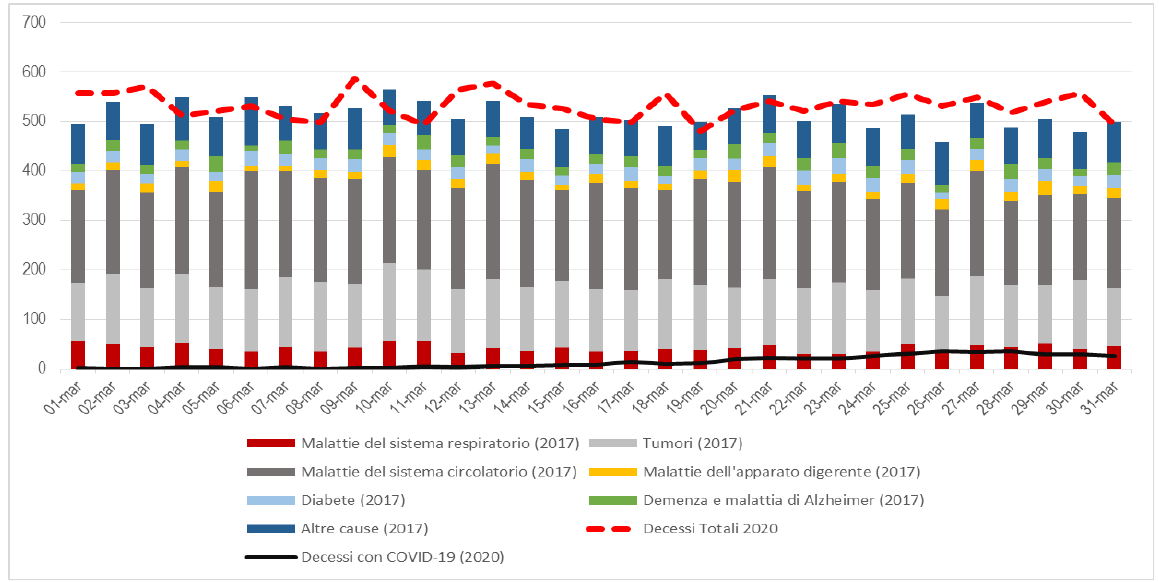
Figura 16 . Confronto tra i decessi giornalieri per le principali cause iniziali di morte a marzo 2017 e i decessi con Covid-19 e per tutte le cause a marzo 2020. Area